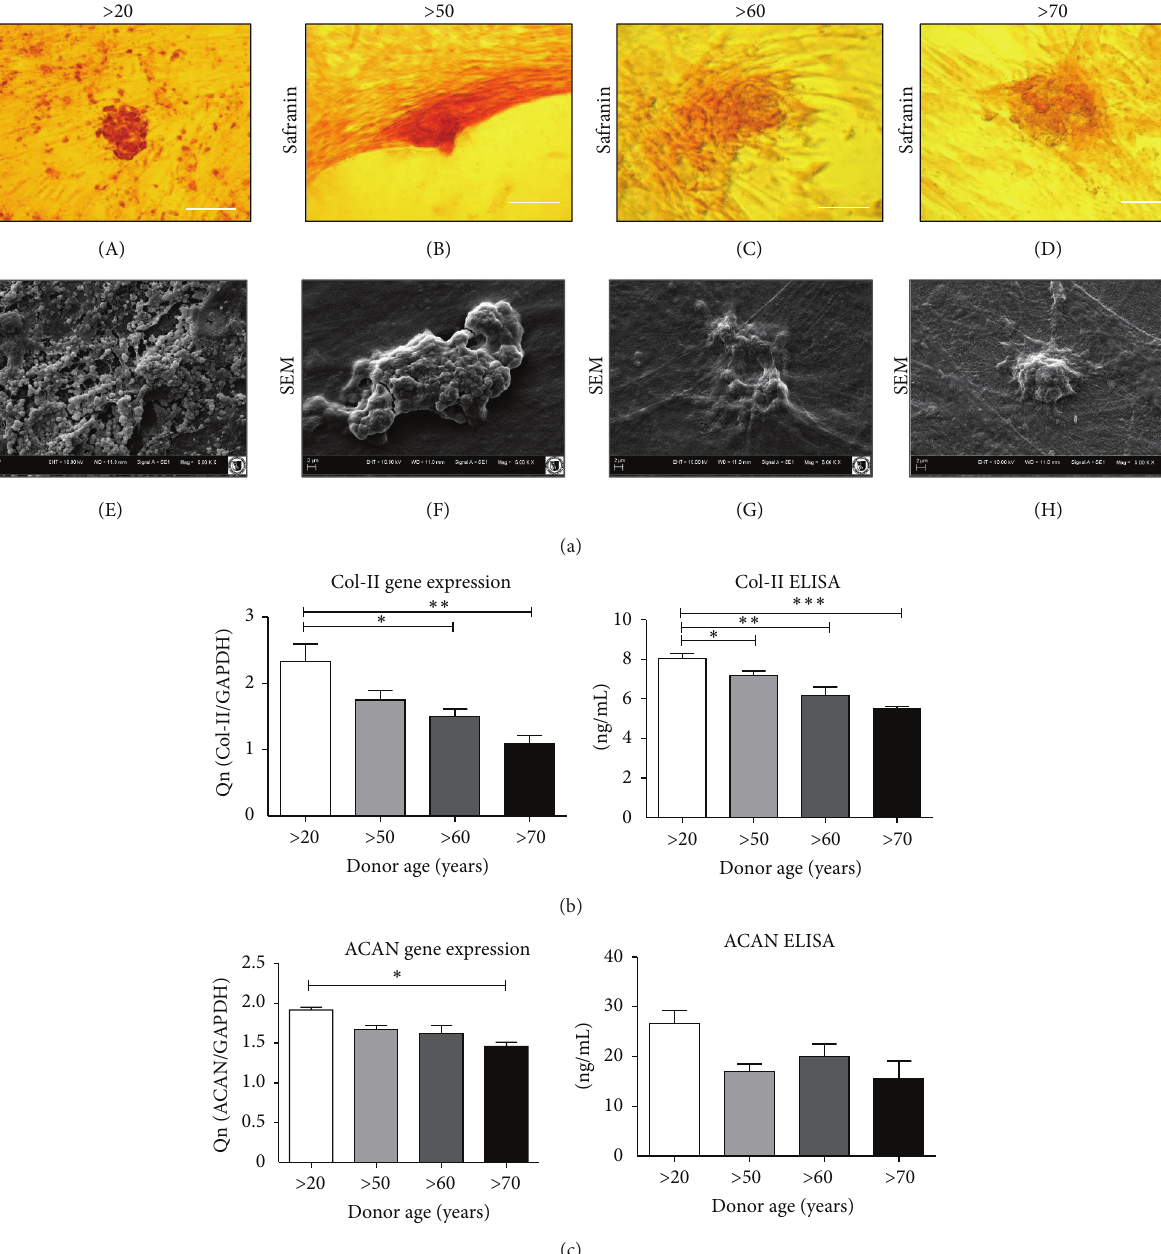
Figure 6: Characterization of age related changes in hASCs chondrogenic differentiation potential. (a) Morphology of cells cultured in chondrogenic medium visualized by Safranin O staining (A–D) and SEM (E–H). Quantitative ELISA analysis and gene expression of (b) Col-II and (c) ACAN. Results expressed as mean ± SD. ∗ 𝑝 value <